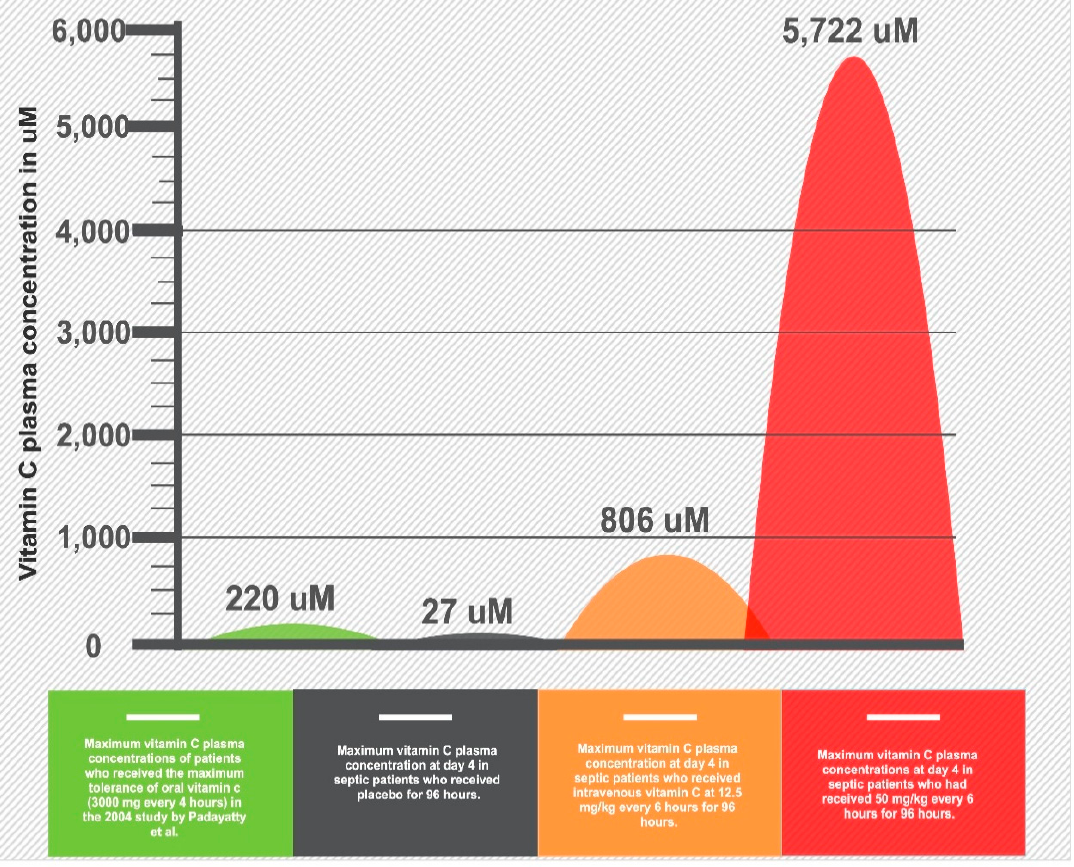
Figure 3. Infographic of di ff erential vitamin C peak plasma concentrations based on alternative routes of administration and dosage.